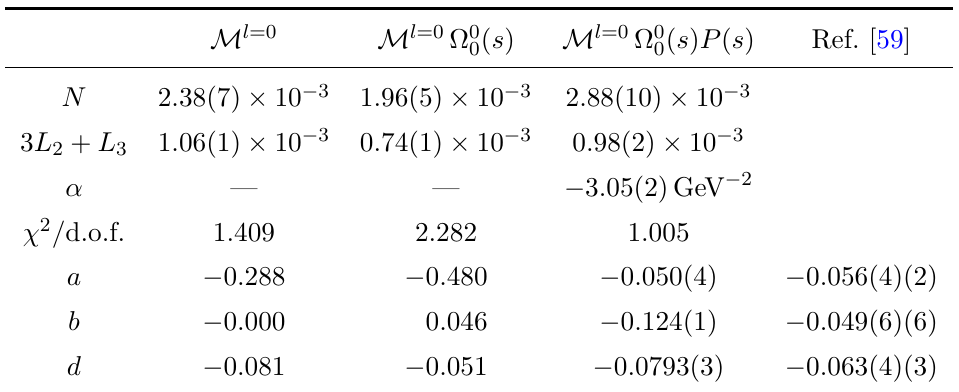
Table 4 . Results for the combined fit for all three models. Presented are the fit parameters as outcome of the minimization routine of χ 2 and the respective Dalitz slope